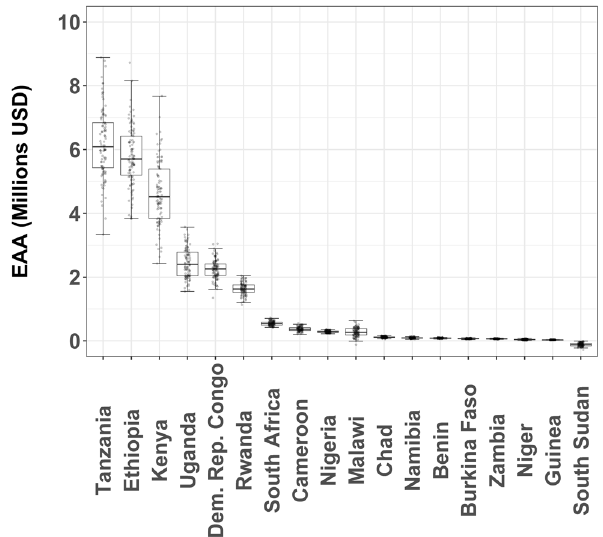
Fig. 3 Boxplot of the equivalent annual annuity (EAA) of building and maintaining mitigation fences in areas at severe risk of con fl ict between humans and African lions ( Panthera leo ) and African elephants ( Loxodonta africana and Loxodonta cyclotis ). Whiskers represent range from minimum to maximum, box indicates 25 and 75 percentile, and horizontal line represents median. Plotted dots represent 100 EAA values calculated by varying all economic model parameters randomly across ±10% of the values of each parameter. Dots outside the whisker boundaries are outliers. Calculations do not consider the additional bene fi t of reducing costs of human injury or